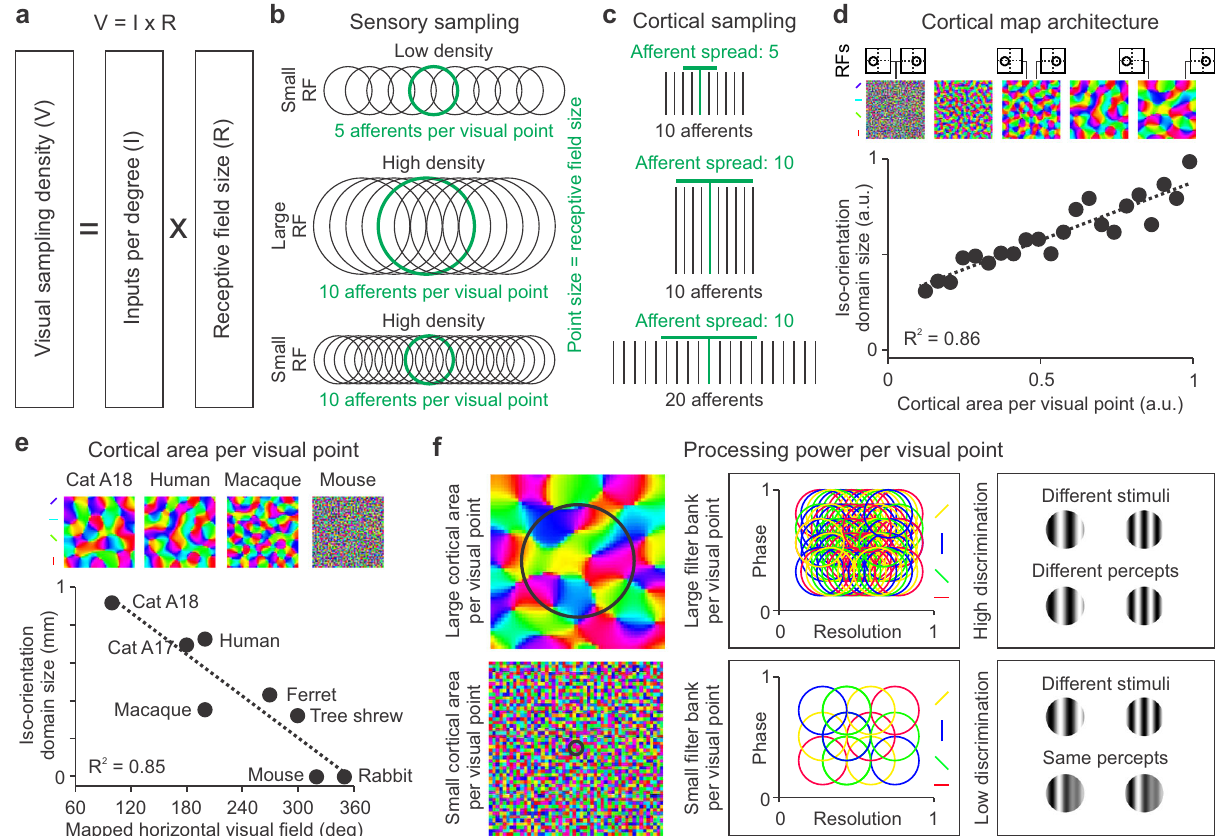
Fig. 10 Sensory cortical maps maximize the balance between spatial resolution and cortical processing power. a Cartoon illustrating the de fi nition of visual sampling density (V) as the multiplication of receptive fi eld size (R) times input afferents per degree (I). b Cartoon illustrating a horizontal rectangle of visual space sampled by 5 afferents with small receptive fi elds (top), 10 afferents with large receptive fi elds (middle) and 20 afferents with small receptive fi elds (bottom). The central receptive fi eld (in green) illustrates the size of the visual point (point size = receptive fi eld size) and the number of afferents per visual point. c Cartoon illustrating the spread of the afferent axonal arbor for each of the three examples shown in ( a ). Because the axon arbor spreads to cortical locations with overlapping retinotopy, the spread is larger when there is an increase in receptive fi eld size (compare top and middle) or afferent density (compare top and bottom). Therefore, the size of the cortical region sampled by each afferent (axon arbor spread) depends on both receptive fi eld size and input density. d In the model, the size of the iso-orientation domains increases with the size of the iso-retinotopic domains (cortical area representing the same visual point), as shown in a scatter plot (bottom, a.u.: arbitrary units) and example orientation maps (top). The size of the cortical area representing the same visual point is illustrated by two vertical lines separating regions with non-overlapping receptive fi elds (RFs). e The model predicts that the size of iso-orientation domains should decrease when the cortex has to map a large visual fi eld and devote smaller areas to represent each visual point (top). Size measurements of iso-orientation domains and horizontal visual fi elds mapped in different cortical areas con fi rm this prediction. f In the model, larger iso-orientation domains (left) accommodate larger fi lter banks per visual point that sample spatial-frequency/phase combinations more fi nely (middle). As a consequence, the model predicts that cortices with larger iso-orientation domains should allow higher stimulus discrimination per visual point. Source data are provided as a Source Data fi